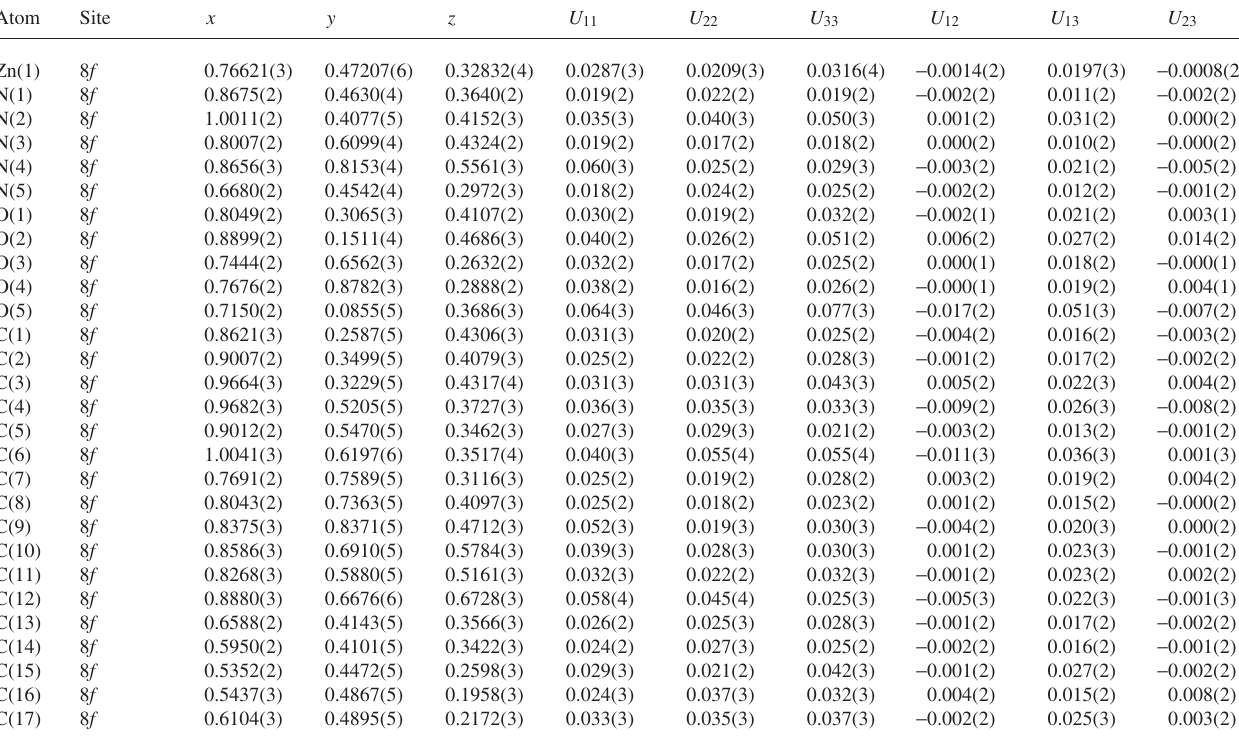
Table 3. Atomic coordinates and displacement parameters (in Å 2 )